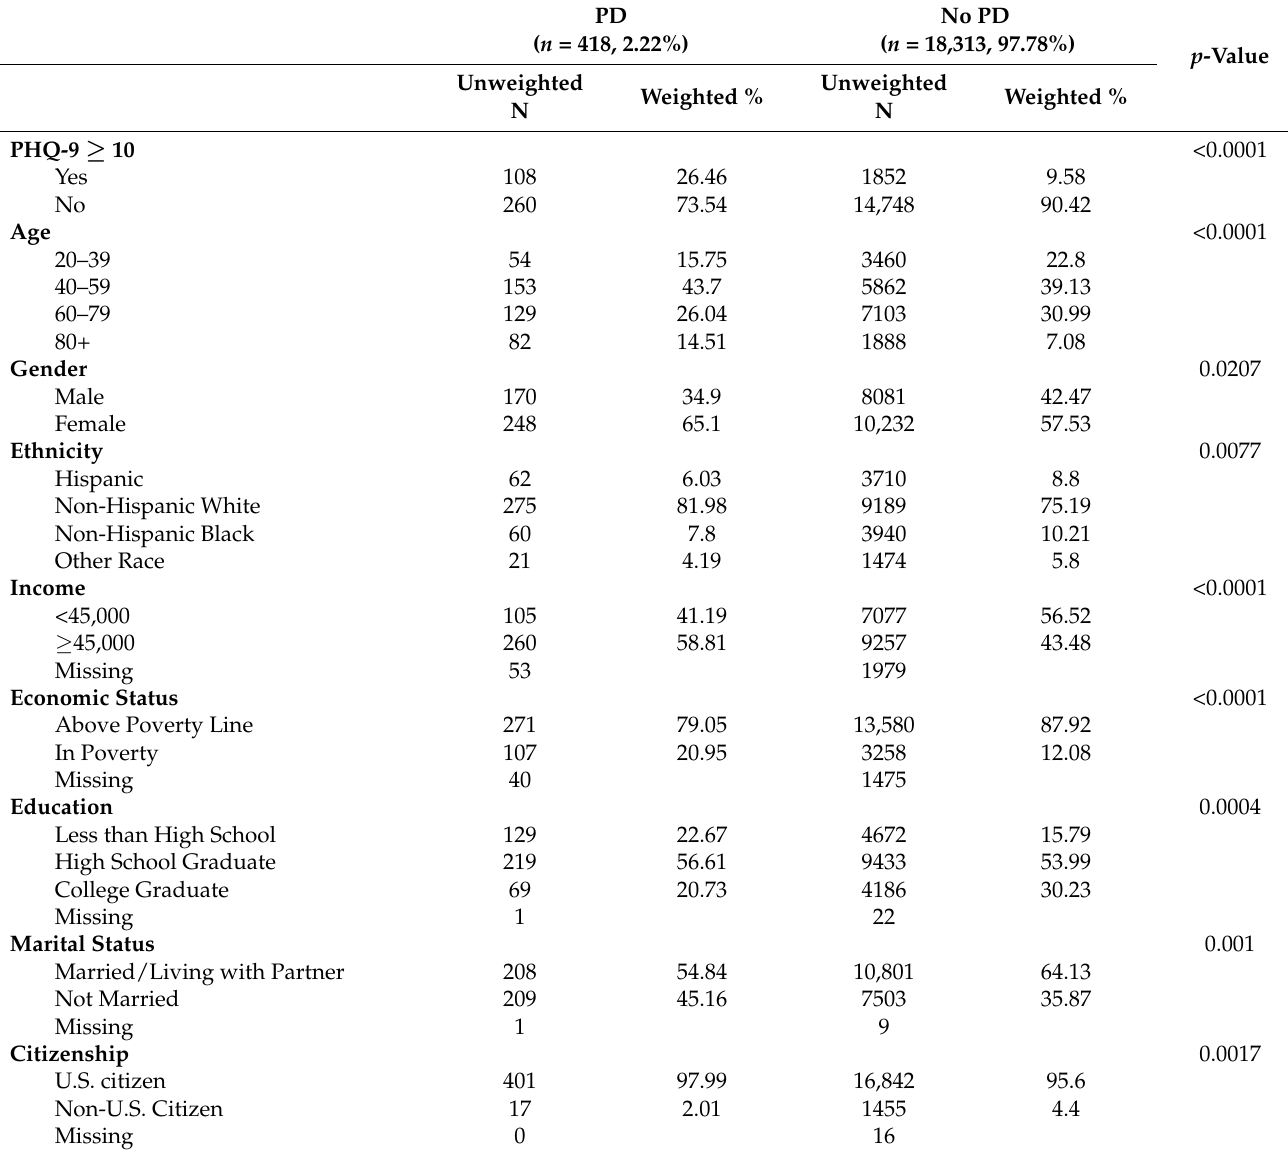
Table 2. Comparison of Patients With and Without Parkinson’s